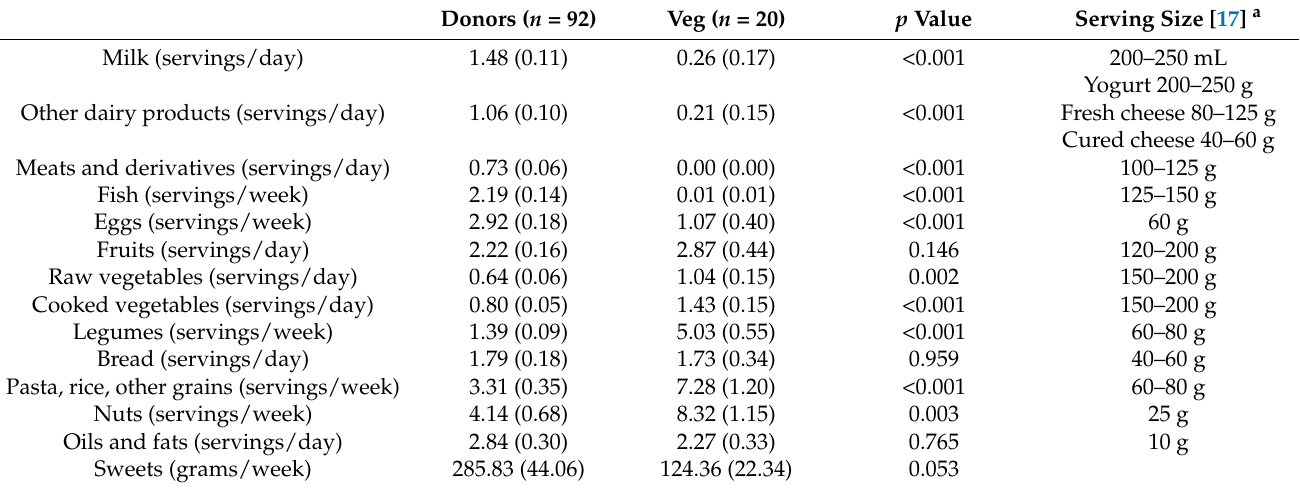
Table 8. Diet survey: food consumption frequency questionnaire (FFQ, the number of food servings per day or week that were consumed by the participants) of the omnivore human milk donors with full-term infants (Donors) and vegetarian/vegan mothers